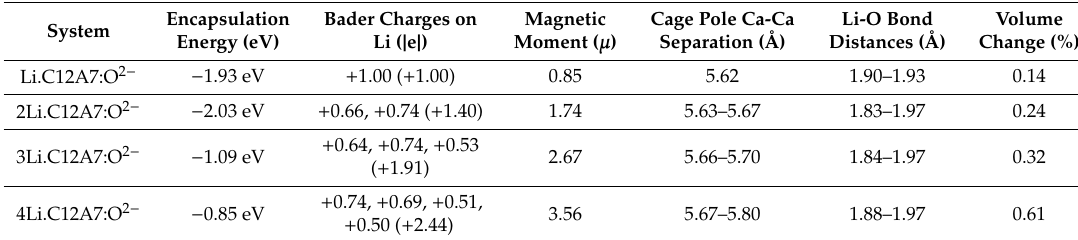
Table 1. Encapsulation energies, Bader charges on the encapsulated Li atoms, magnetic moments of the encapsulated complexes, Ca-Ca cage pole distances, Li-O bond distances and volume changes due to the encapsulation. Total Bader charges are shown in